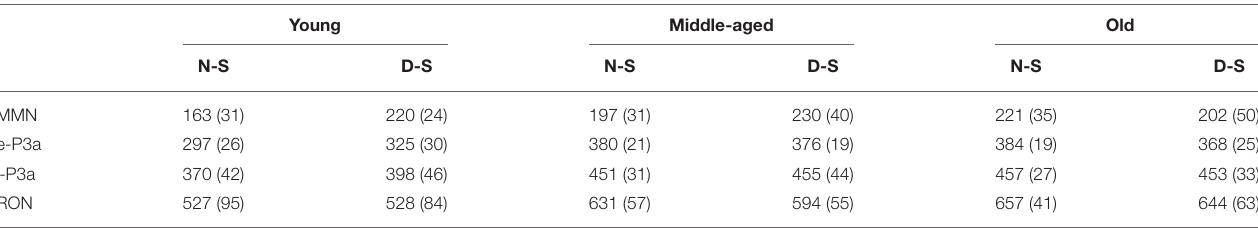
TABLE 2 | Mean values and standard deviations (in brackets) of latencies (ms) for MMN (100–250ms), e-P3a (280–400ms), l-P3a (350–500ms), and RON (400–700ms) components at Cz, in the novel minus standard (N-S) and deviant minus standard (D-S) difference waveforms, for the three age groups (Young, Middle-aged,